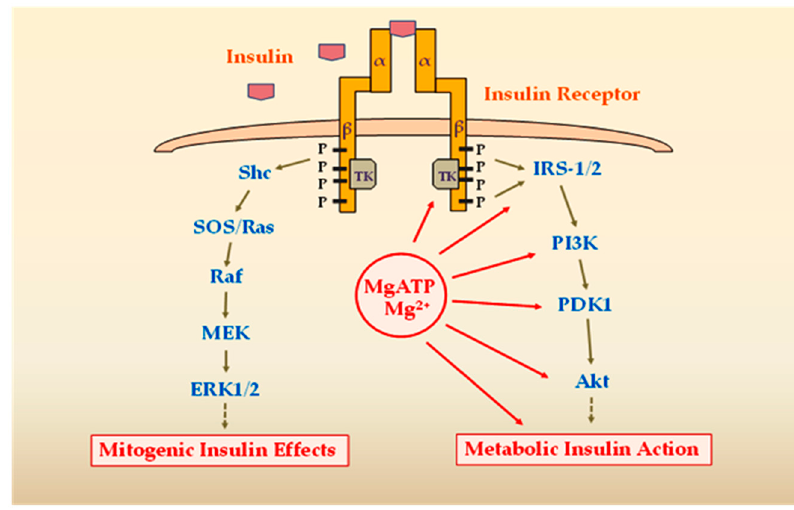
Figure 2. Schematic diagram showing the two major insulin signaling pathways and the role of Mg 2+ in metabolic signaling. The Ras/MAPK pathway regulates gene expression and insulin-associated mitogenic effects. The PI3K/Akt kinase pathway regulates the metabolic actions of insulin, which include glucose uptake by GLUT4 mobilization, glycogen and protein synthesis, and lipogenesis. Intracellular Mg 2+ concentrations are critical for the phosphorylation of INSR and the activity of other signal kinases, where Mg 2+ operates together with ATP as a kinase substrate. Mg 2+ may exert regulatory influence on TK of INSR and other enzymes, mediating the metabolic effects of insulin.